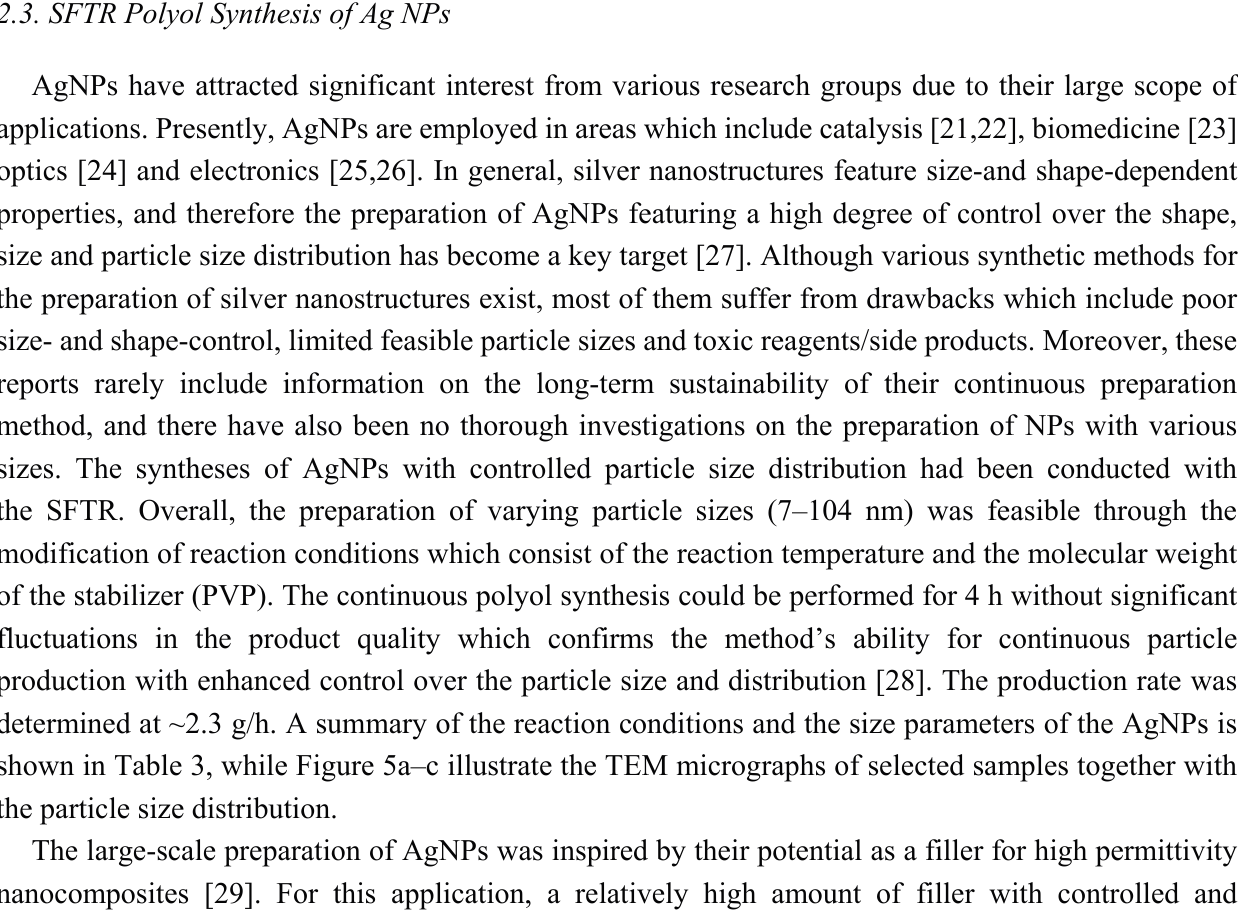
Table 3. Summary of the reaction conditions and the size parameters of the prepared AgNPs.